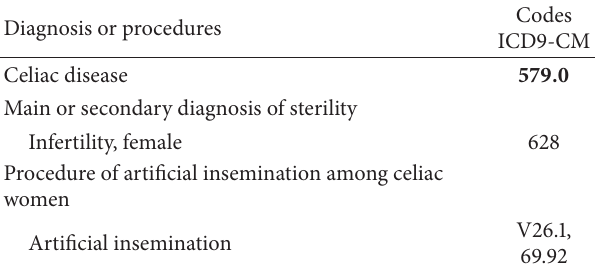
Table 1: ICD9-CM of diagnosis or procedures and exemption codes considered in the population analysis, years